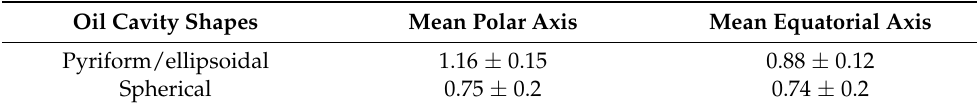
Table 1. Dimensions of C. lumia ‘Pyriformis’ oil cavities at the maturity stage measured on light micrographs.